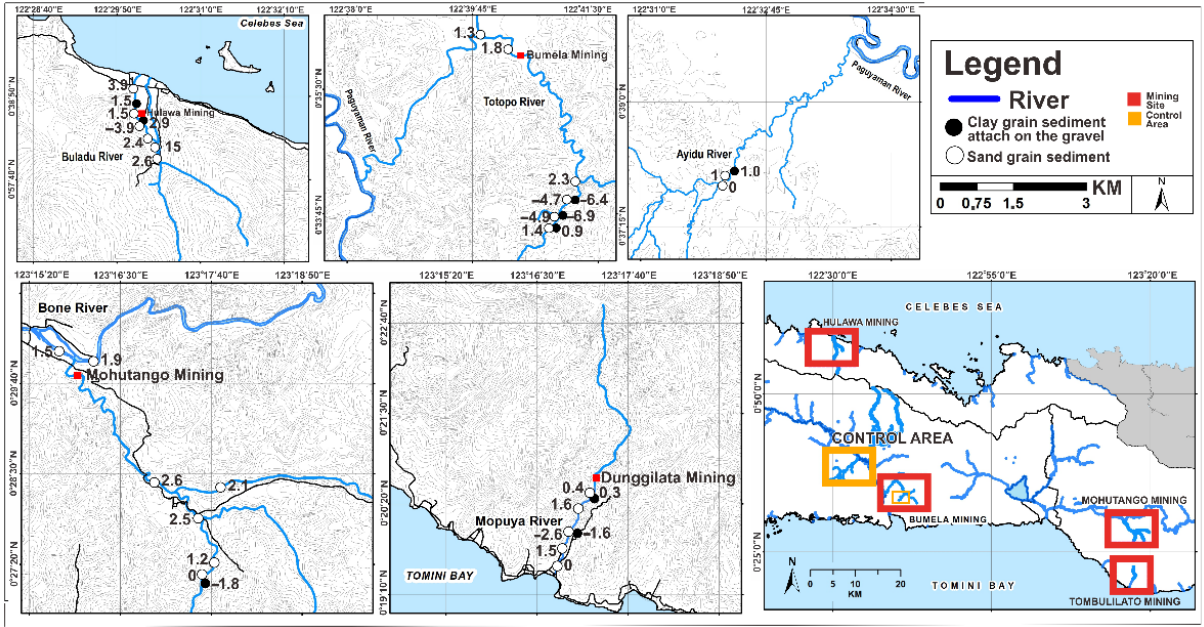
Figure 5. Plots of I geo and contaminant levels in Zn along the river sediments in Gorontalo Province, Indonesia (µg/g).